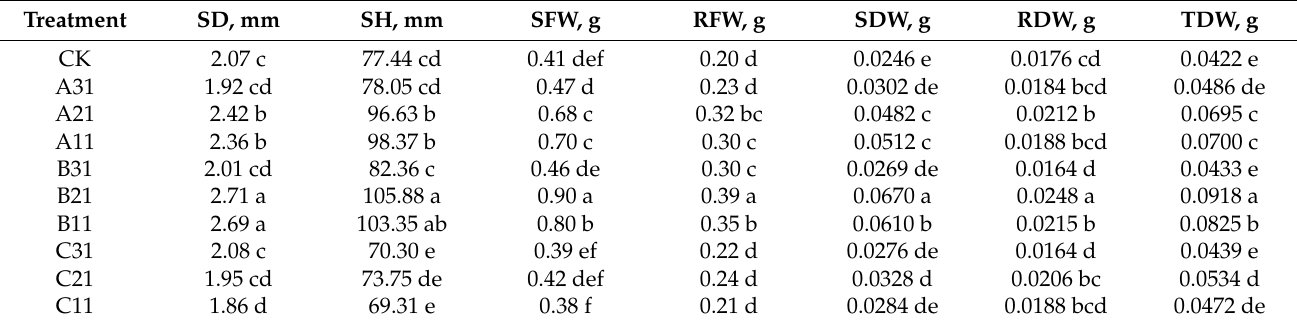
Table 2. Physical properties of plug seedlings treated with different